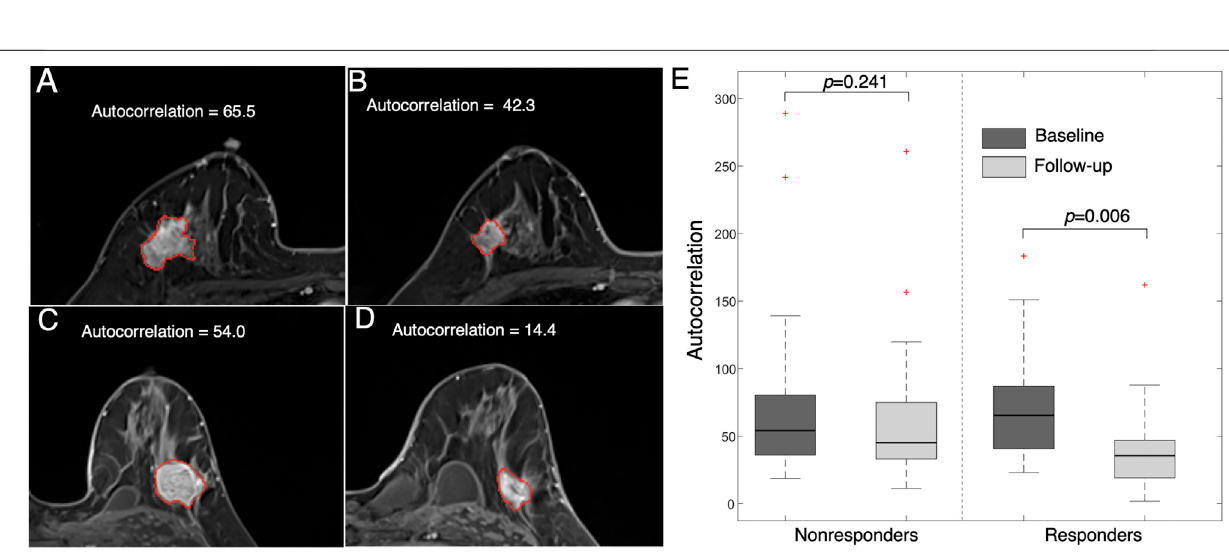
FIGURE 6 | Images representing feature (autocorrelation) changes between pre- and post-treatment images. Images from a 47 year-old woman who responded to NACT (high MP grade) at (A) baseline (autocorrelation (cid:1) 65.5) and (B) follow-up (autocorrelation (cid:1) 42.3). Images from a 36 year-old woman who did not respond to NACT(lowMPgrade)at (C) baseline(autocorrelation (cid:1) 54.0)and (D) follow-up(autocorrelation (cid:1) 14.4). (E) Boxplotshowingthatthefeaturevalueissigni fi cantlyreduced in responders ( p (cid:1) 0.006) but is not signi fi cantly changed in nonresponders ( p (cid:1)